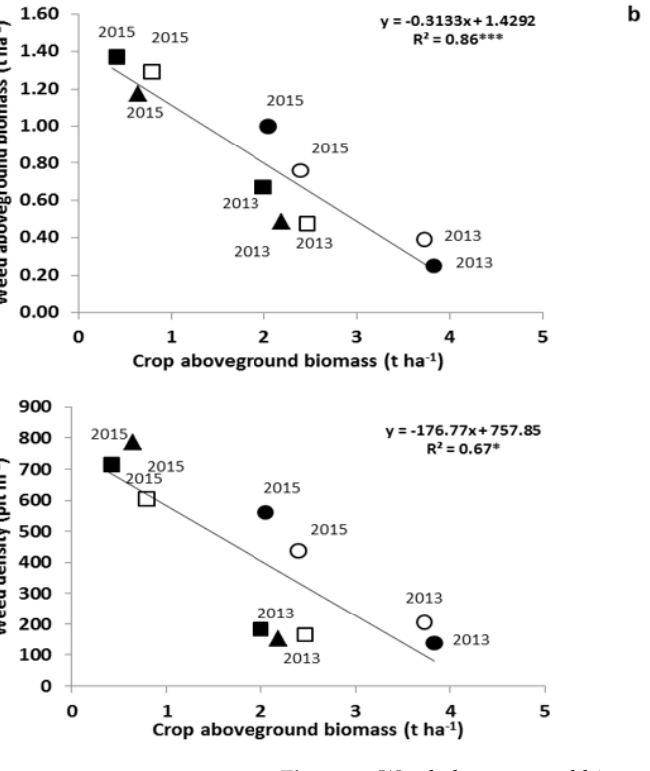
Figure 4. Weed aboveground biomass (t ha − 1 ) as a function of the crop aboveground biomass ( a ) and crop soil N uptake ( b ), and weed density as a function of crop aboveground biomass ( c ) for all treatments. Linear regression was carried out for the combined two years and included both the sole and intercropped treatments after winter in February. “*”, “**”, “***” indicate that a regression is significant at p < 0.001, p < 0.05, p < 0.01, respectively, according to the table proposed by Fisher and Yates (1938) [65].